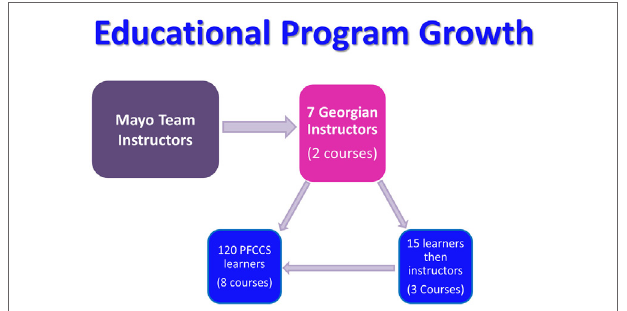
Figure 3 | Program growth within local resources at the completion of six